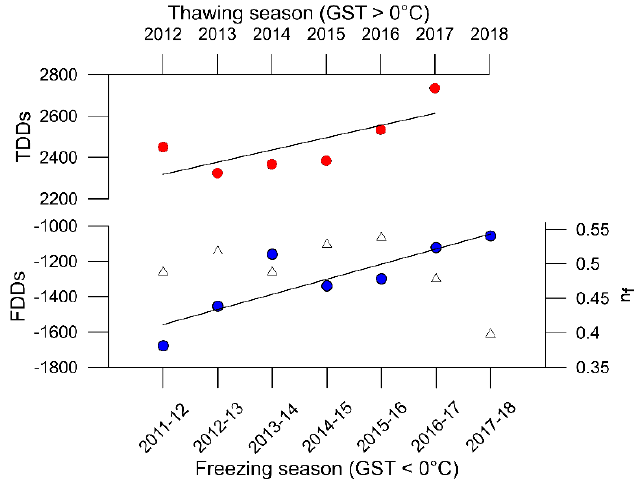
Figure 3. Observed surface thawing (TDD s ) and freezing (FDD s ) degree-days and the insulating effect of snow (n f ) (triangles) at the hydro-climatic station since 2011. GST represents the ground surface temperature.